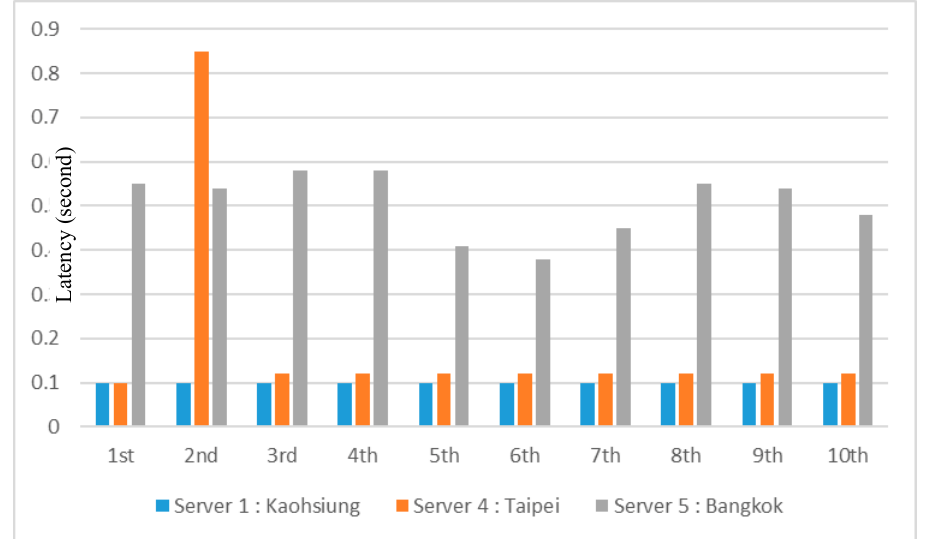
Figure 22. Latency test for command using ADSL communication; latency time in seconds on Y axis, test number on X axis.